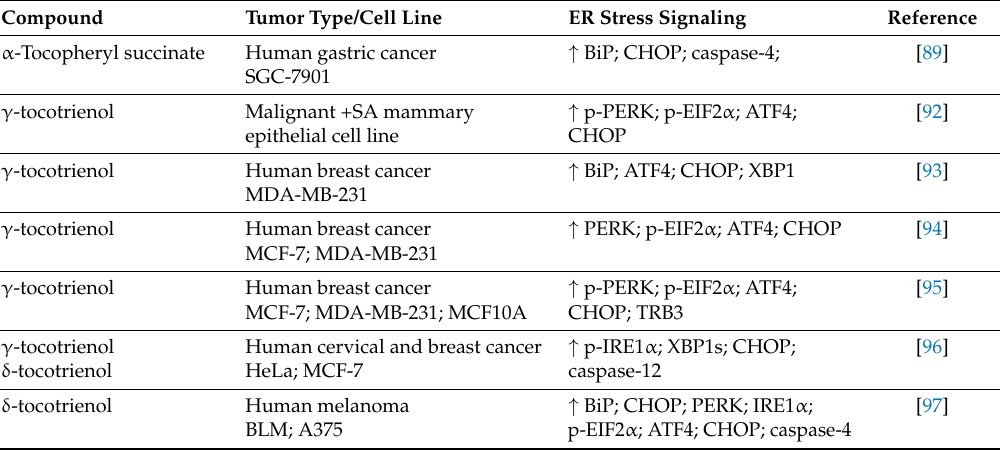
Table 4. Tocotrienols with ER stress-mediated anticancer